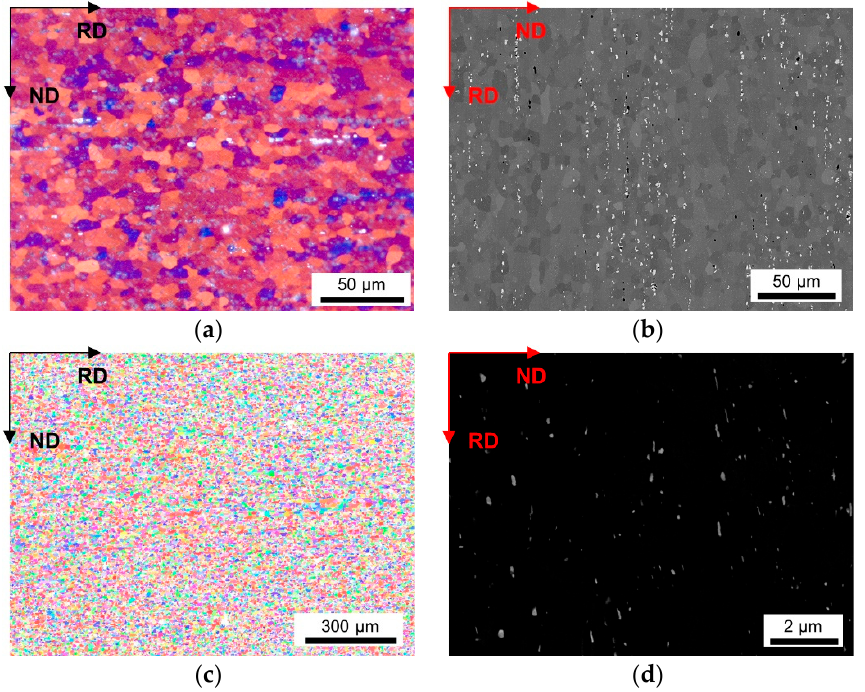
Figure 4. Microstructure of the soft annealed HFe-HMn cast under NR-C condition, homogenized at 500 °C and cold rolled to a CRD of 63%. ( a ) LOM. ( b ) BSE image. ( c ) EBSD IPF map in RD–ND plane. ( d ) BSE micrograph showing dispersoids.